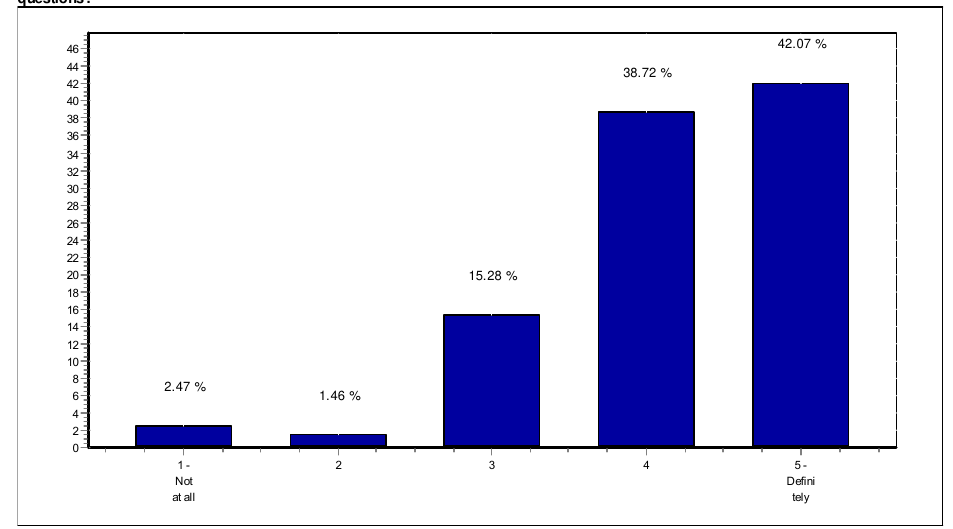
Fig. 1. Extent to which advisors have sufficient practical knowledge to answer